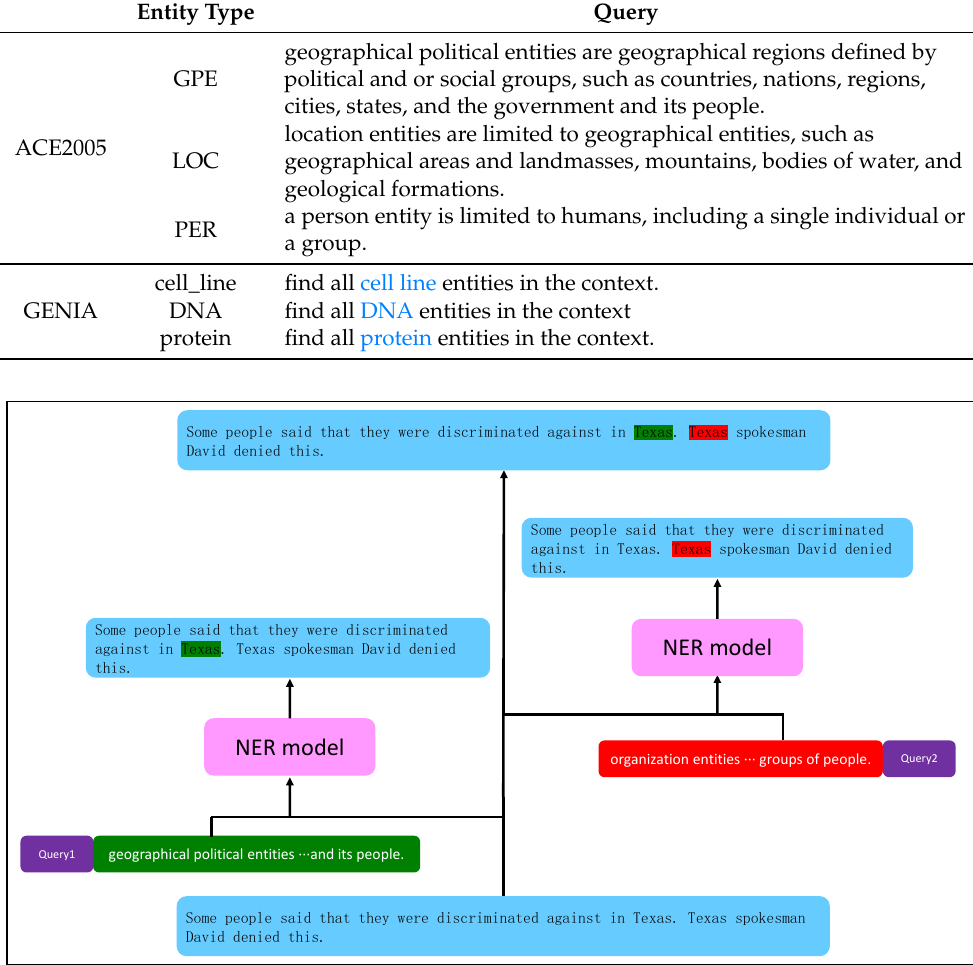
Table 1. Example of converting different entity categories into question queries. If the annotation information of the entity type exists, it is summarized as a query, as shown in the queries correspond- ing to the GPE, LOC and PER types in the ACE2005 dataset. If the label information of the entity type